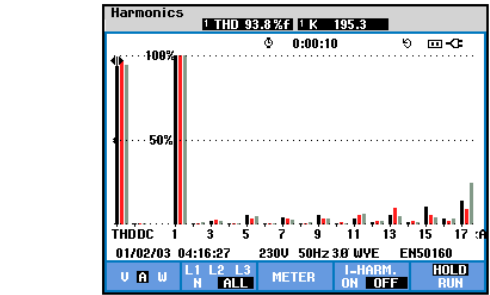
Figure 23. Waveforms of grid current and its harmonic spectra with common control strategy shunt APF prototype carrying active load and three-phase rectifier loads.